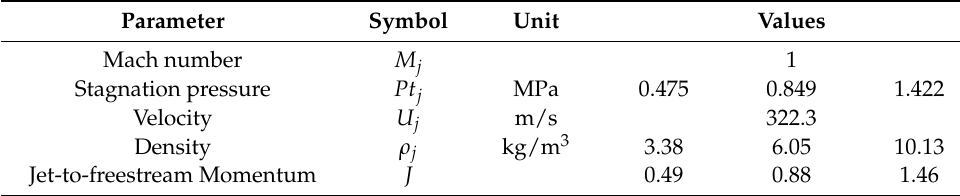
Table 3. Identification and conditions of the 15 tests carried out during the experiments.